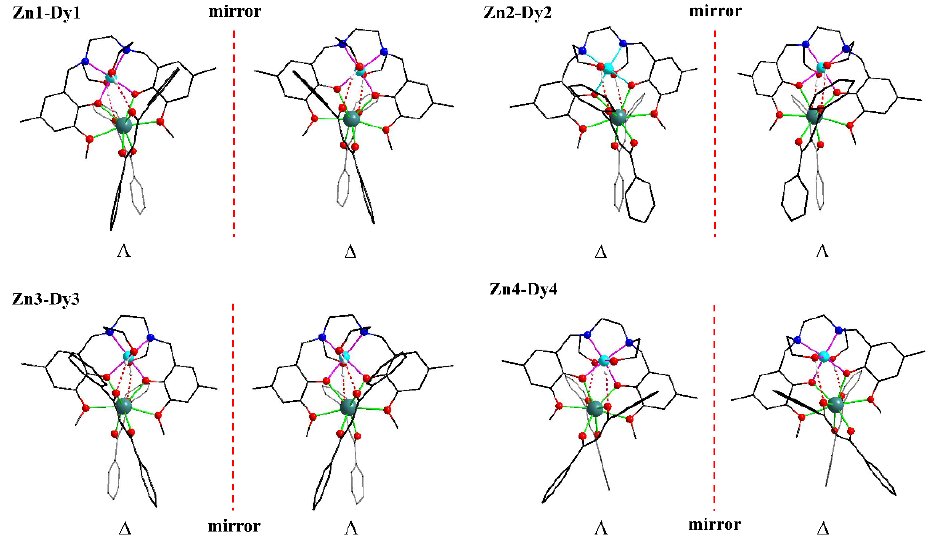
Figure 3. Coordination environments of Zn1-Dy1, Zn2-Dy2, Zn3-Dy3 and Zn4-Dy4 in complexes 1a ( left ) and 1b ( right ). Some hydrogen atoms are omitted for clarity.